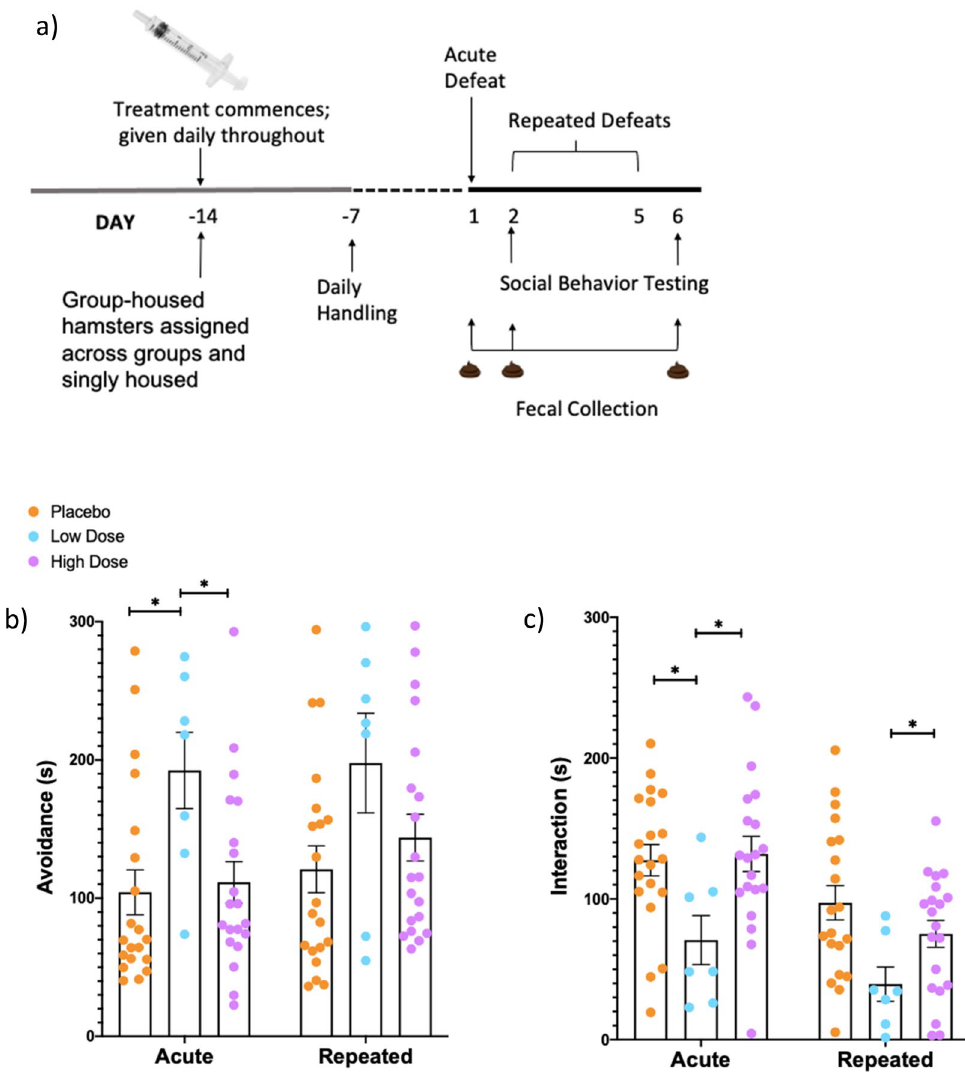
Figure 1. Probiotic intervention at a low dose increases susceptibility to social stress. ( a ) A timeline for the study is shown in ( a ). Following the acute defeat, hamsters treated with a low dose of the probiotic ( n = 7) (blue dots) avoided a novel opponent more ( b ) and interacted with the opponent less ( c ) than did hamsters treated with a high dose of the probiotic ( n = 20) (purple dots) or the placebo ( n = 20) (orange dots) (* p < 0.05). Following repeated defeats, there were no significant differences in avoidance behavior between treatment groups ( b ), yet hamsters treated with the lose dose (n = 7) (blue dots) interacted with a novel opponent significantly less than did placebo-treated hamsters ( n = 20) (orange dots) ( c ; * p < 0.05). Data presented as mean +/− standard error of the mean. Note that the videos for three animals in the low dose probiotic group were lost due to a technical problem, so the group n for behavioral analysis is lower than for the other measures